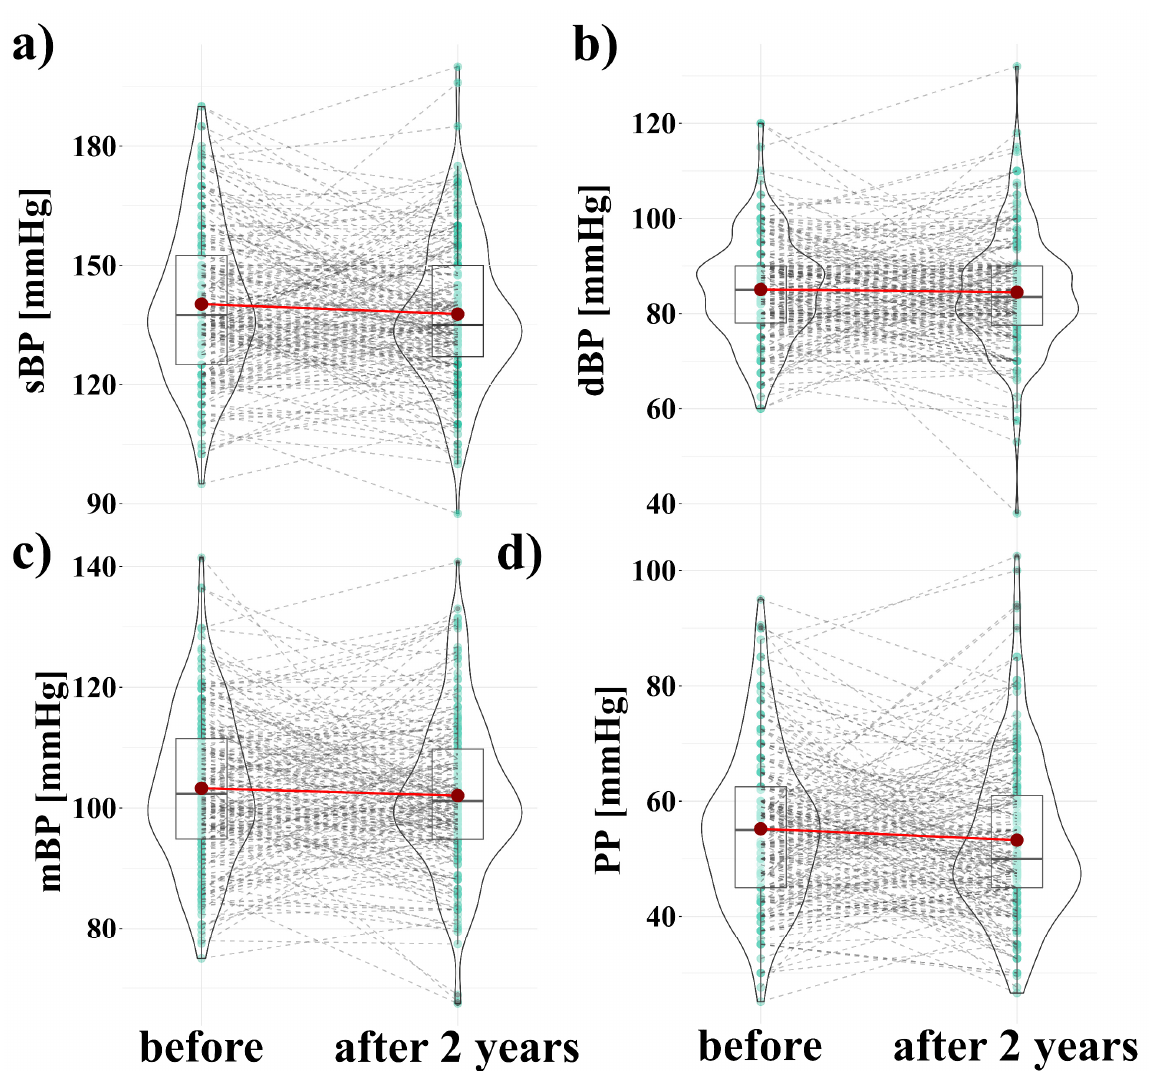
Figure 2. Changes of blood pressure within two years. ( a ) change in systolic blood pressure (sBP) before vs. after 2 years, ( b ) change in diastolic blood pressure (dBP) before vs. after 2 years, ( c ) change in mean blood pressure (mBP) before vs. after 2 years, ( d ) change in pulse pressure (PP) before vs. after 2 years. The shape of the violin graph denotes the distribution of values. A horizontal black line inside the box denotes the median value, while the turquoise dots connected by dashed grey lines indicate the results of individual participants. Dark red dots connected by a light red line indicate the arithmetic mean